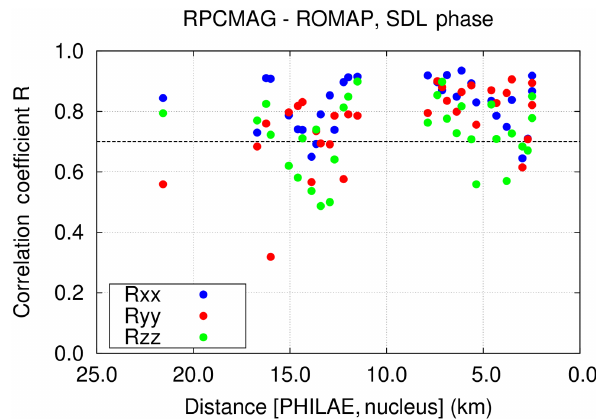
Figure 6. Correlation coefficients R xx (blue), R yy (red) and R zz (green) of the six magnetic field components measured by RPC- MAG and ROMAP. Correlation has been calculated using moving 300s intervals and plotted versus the lander-comet distance. The horizontal line at R = 0 . 7 designates the usual lower confidence